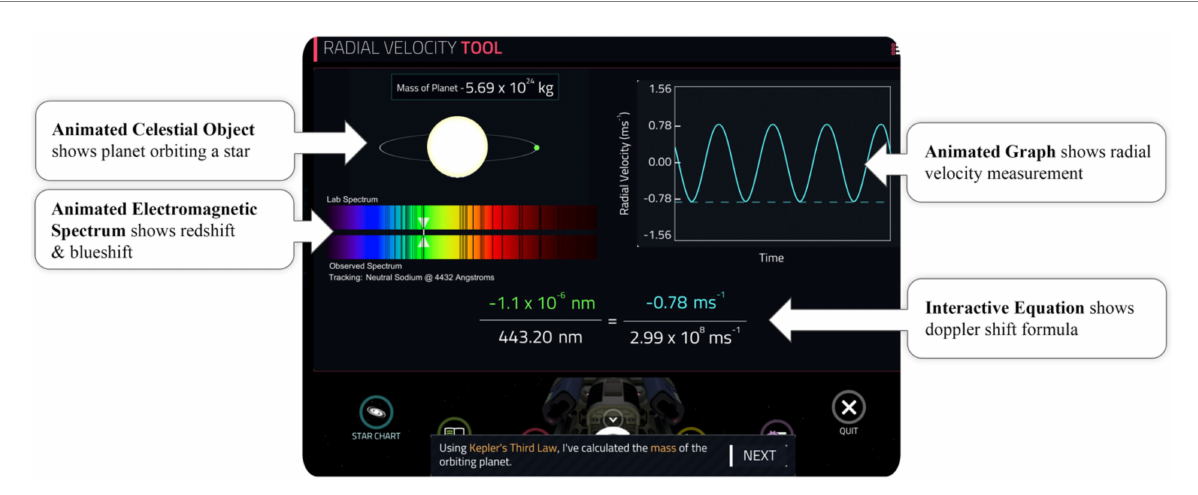
FIGURE 2 Example sense-making task: Students must connect the visual representations related to the Doppler shift: planet orbiting a star (top left), electromagnetic spectrum (bottom left), radial velocity graph (top right), and the corresponding equation (bottom center) to understand the concept of using doppler shift to identify planets orbiting a star. This task is presented in the Radial Velocity Tool of the game, discussed